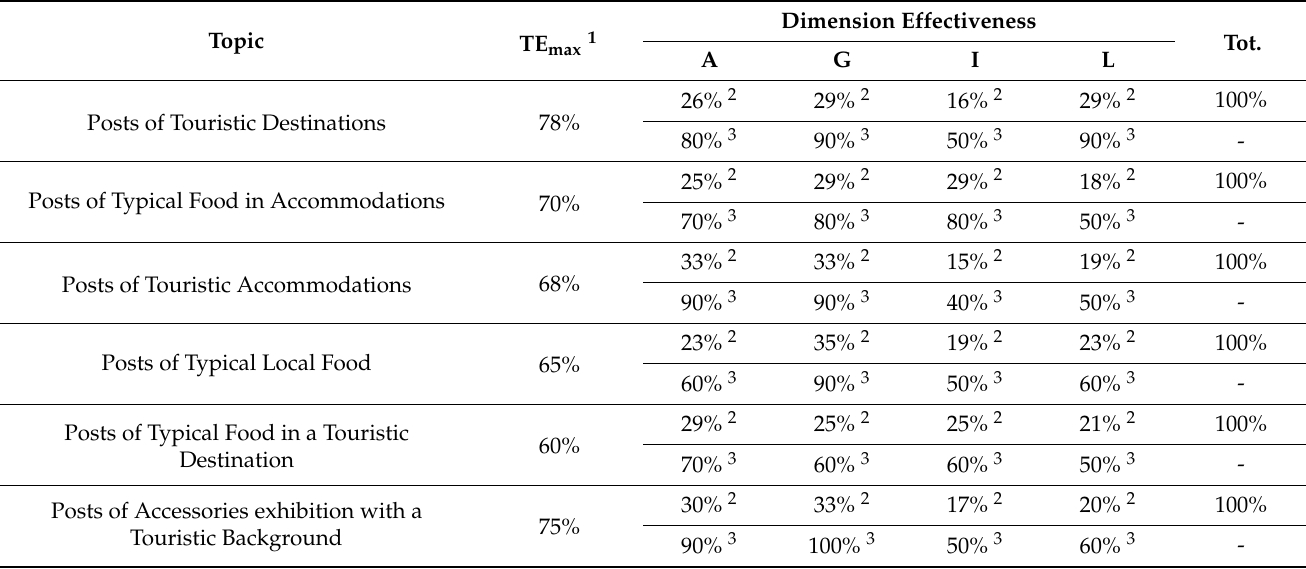
Table 2. Topics (key factors) and values of indexes of Topic overall Effectiveness (TE max ) and Dimension Effectiveness (DE max and DE Σ ) for each topic